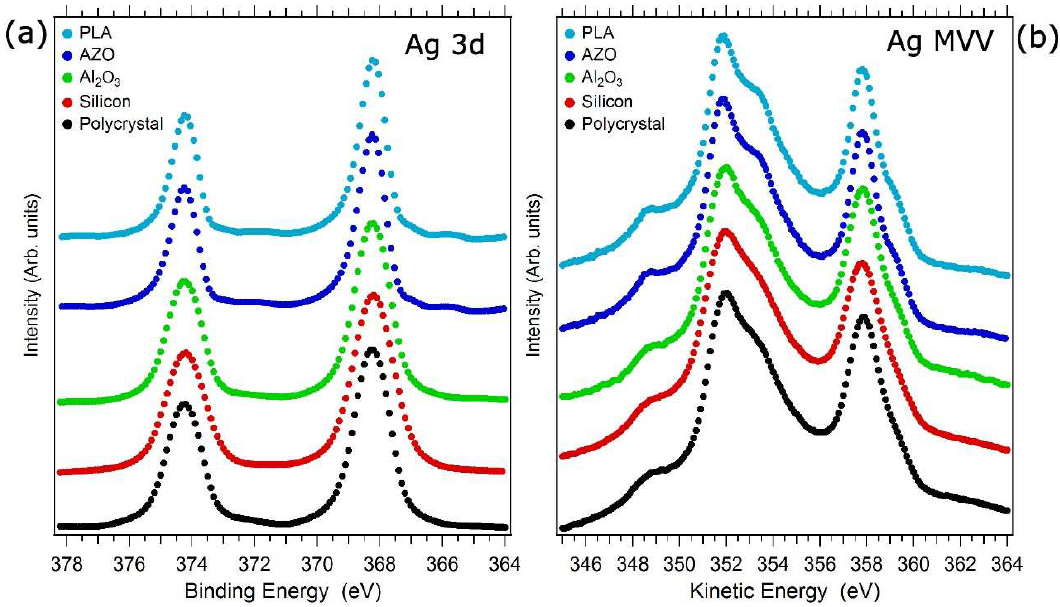
Figure 7. ( a ) XPS Ag 3d core levels and ( b ) Auger MVV Ag emission line obtained from Ag NP film deposited on different substrates. Ag polycrystal and Ag on Al 2 O 3 taken with permission from ref [37]; further permission related to the material excerpted should be directed to the ACS. Silicon, aluminum zinc oxide (AZO), and polylactic acid (PLA), original data. The lines are reported after Shirley-type background subtraction and intensity normalization.